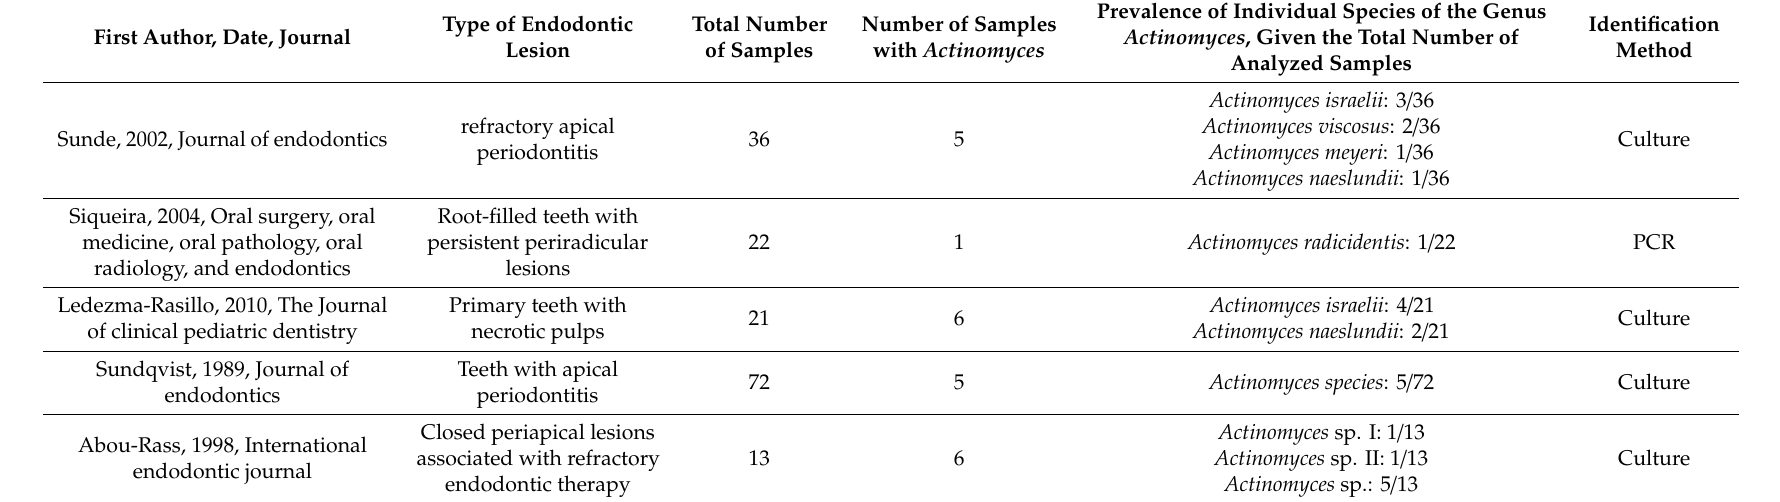
Table 3. Secondary outcome (prevalence of species of the genus Actinomyces given the total number of samples analyzed in each